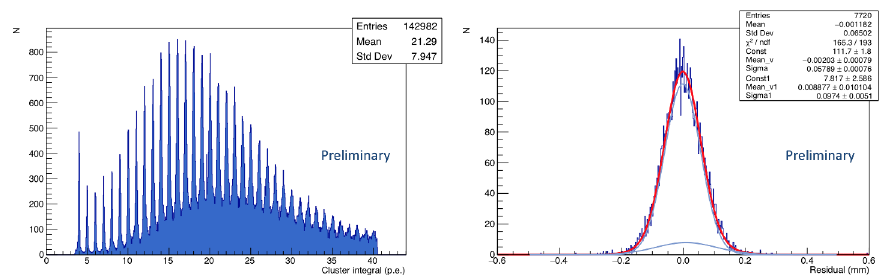
Figure 6. Beam test results for a FIT prototype module made of 1 m length fiber mat and one SiPM array: light yield (left) and hit residual distribution with double Gaussian fits